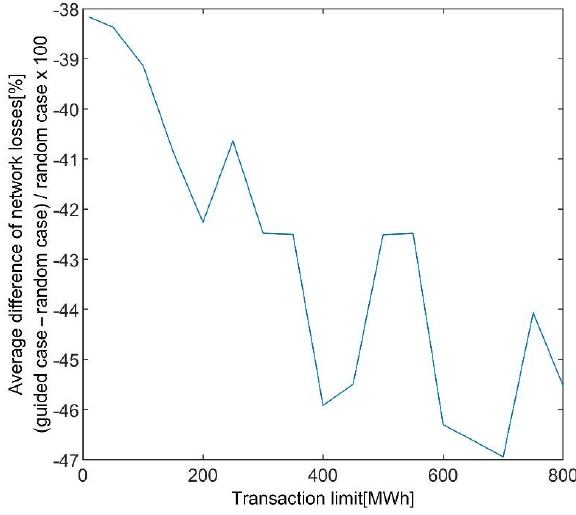
Figure 6. Average difference ratio of network losses between the random case and the guided case in the IEEE 39 bus system.